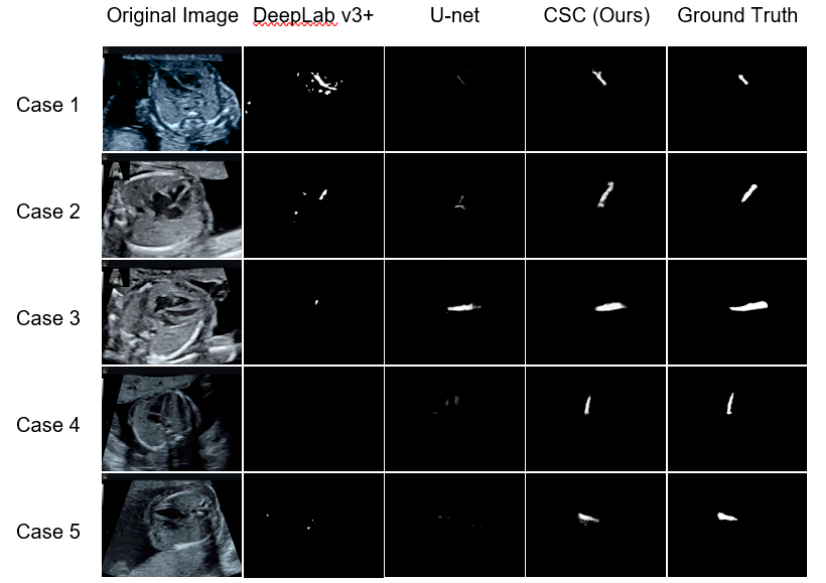
Figure 3. Representative examples of the ventricular septum segmentation images in test data for the existing methods (DeepLab v3 + and U-net) and CSC (Cropping-Segmentation-Calibration). One horizontal row presents the segmentation results with respect to each method for the same case. The white pixels are estimated as the ventricular septum, and the degree of whiteness indicates the confidence level. Among the three methods, the segmentation results of CSC were most in accordance with the ground truth.